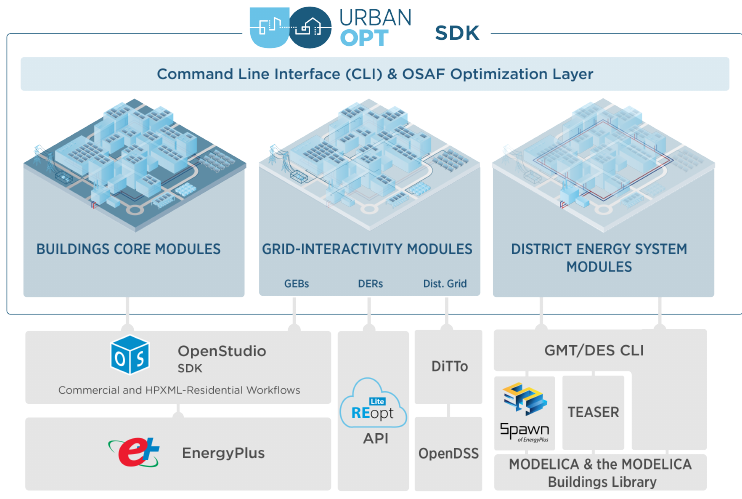
Figure 2. URBANopt modules. Available online: https://docs.urbanopt.net/ (accessed on 28 July